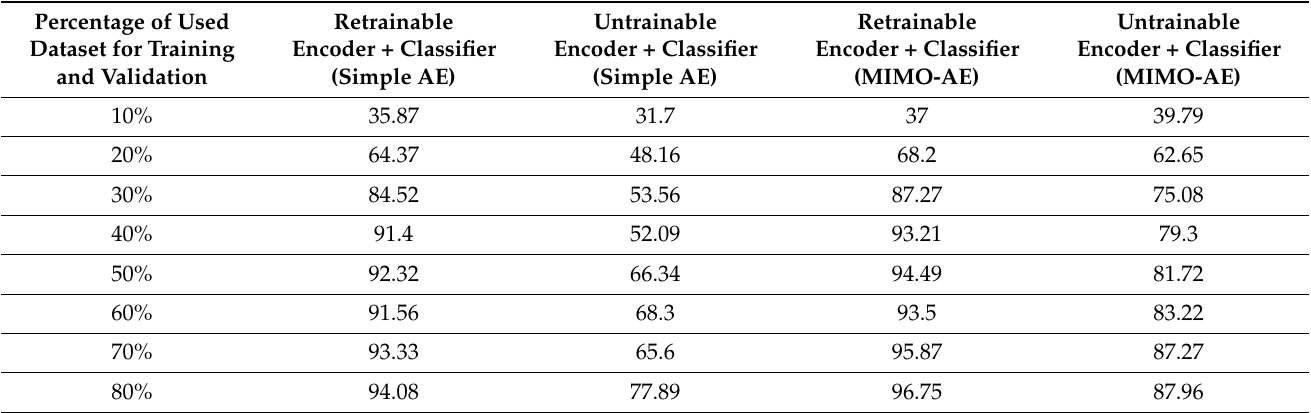
Table 5. Average accuracy comparison of proposed models using different percentages of data, in the case of simple AE versus